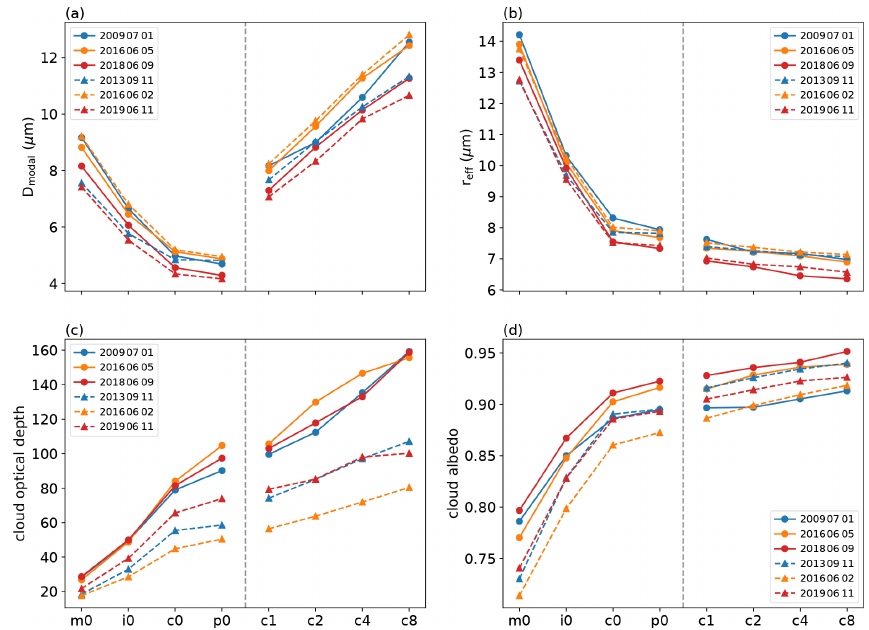
Figure 13. Spatiotemporal averages of the modal diameter in the cloud droplet size distribution D modal (a) , effective radius r eff (b) , cloud optical depth τ c (c) , and synthetic cloud albedo (d)